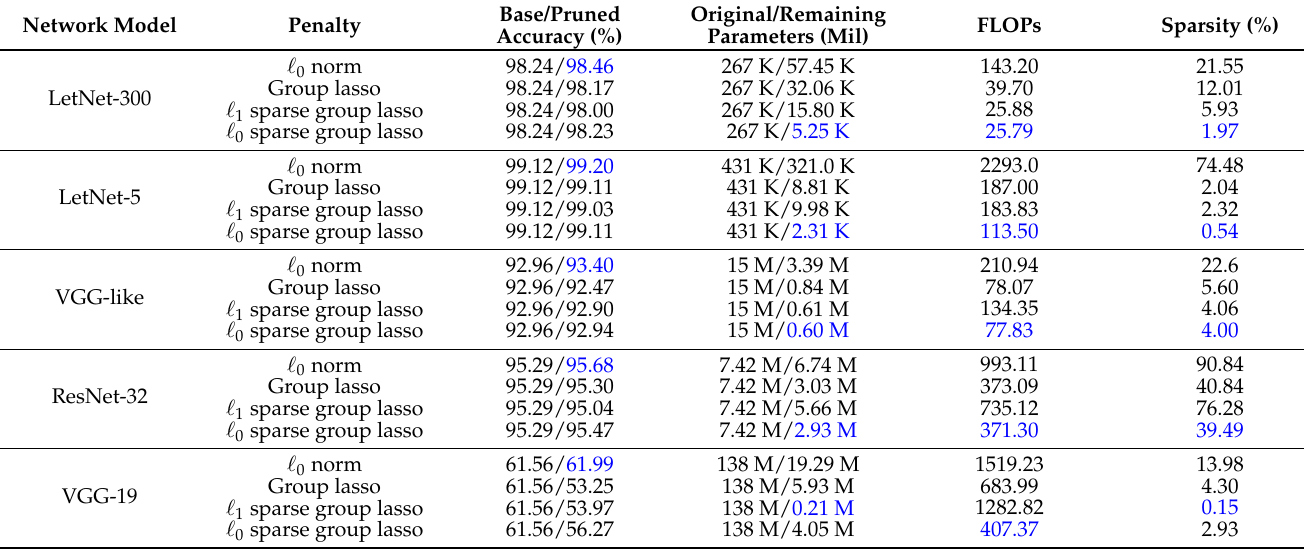
Table 4. Alation studies on various network models. (We mark the best performance as blue among different penalties for each